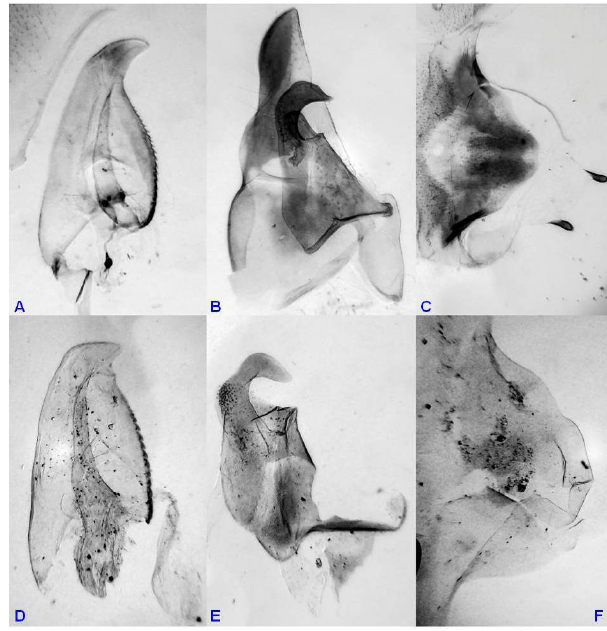
Fig 5 . Dissected genitalia of Iberoformica subrufa (A, B, C) and Formica gerardi (D, E, F). Imaged by Federico